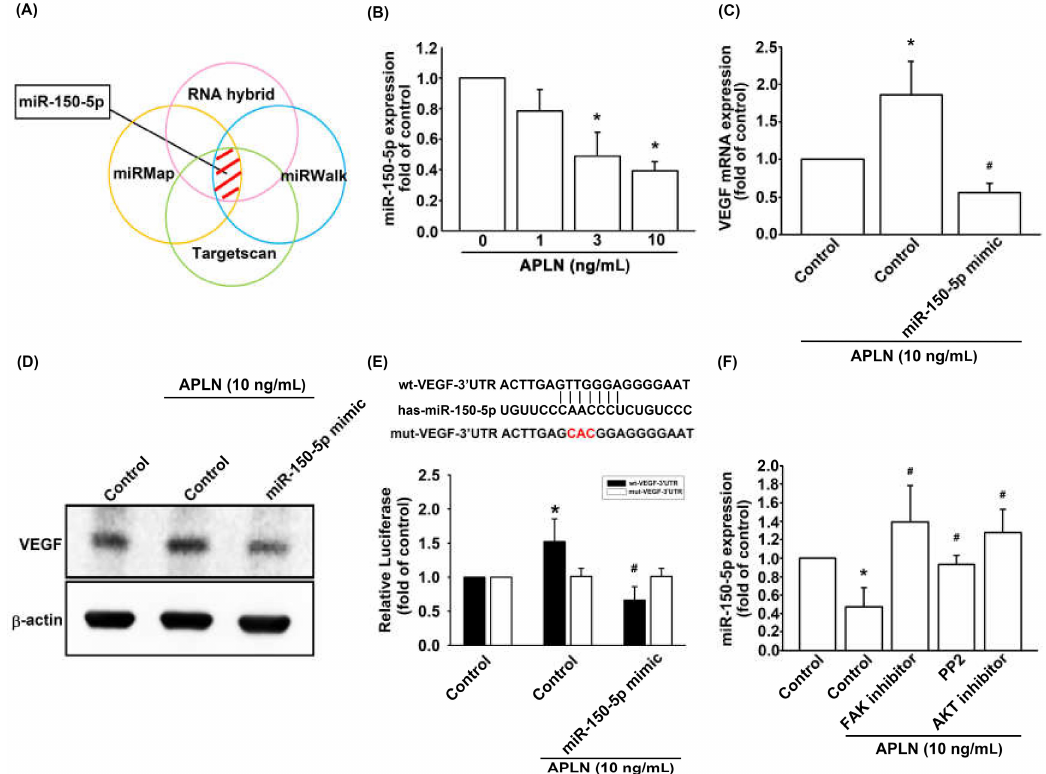
Figure 5. Apelin suppression of miR-150-5p enhances VEGF production. ( A ) Open-source software (TargetScan, miRMap, RNAhybrid, and miRWalk) was employed to determine which miRNAs could potentially inhibit VEGF transcription. ( B ) OASFs were incubated with APLN. miR-150-5p expression levels were examined using RT-qPCR assay ( n = 4). ( C , D ) OASFs were transfected with miR-150-5p mimic and then stimulated by APLN. ( C ) VEGF transcription and ( D ) translation levels were examined using RT-qPCR ( n = 4) and ELISA assays ( n = 5). ( E ) OASFs were transfected with the mt-VEGF-3 (cid:48) UTR plasmid with or without miRNA-150-5p mimic, then incubated under APLN. Relative luciferase activity reflected VEGF promoter activity ( n = 6). ( F ) OASFs were treated with FAK, Src, or Akt inhibitor then incubated with APLN. miR-150-5p expression levels were examined using RT-qPCR assay ( n = 4). * p < 0.05 compared with control; # p < 0.05 compared with the APLN-treated